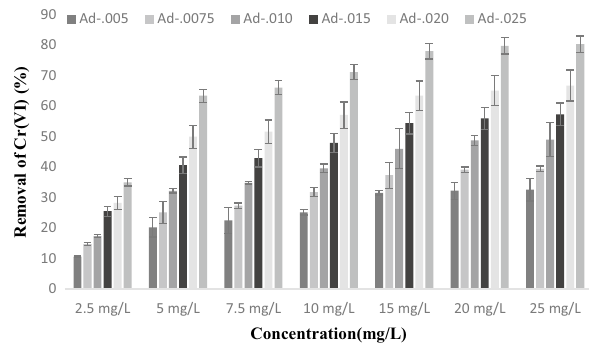
Fig. 6 Combined effect of initial concentration and adsorbent dose on chromium removal